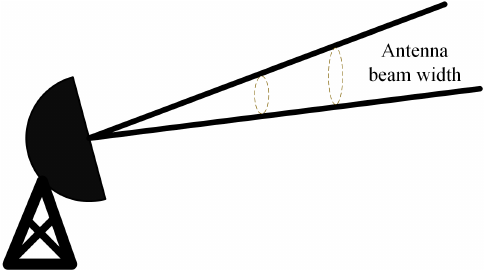
Figure 1. The effect of the radar beam. Table 2. The radar azimuth resolution at different detection distances.